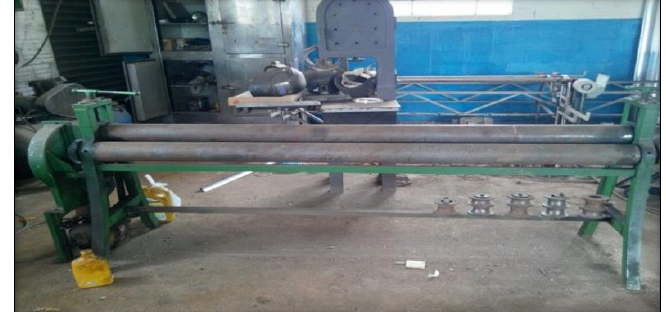
Figure 1: Sheet Metal Forming